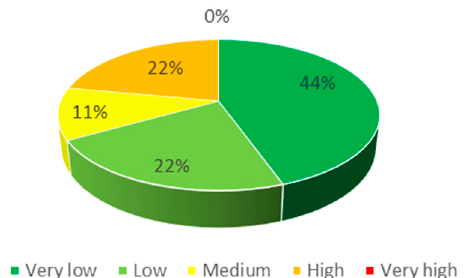
Figure 4. Buildings’ location in the study area.